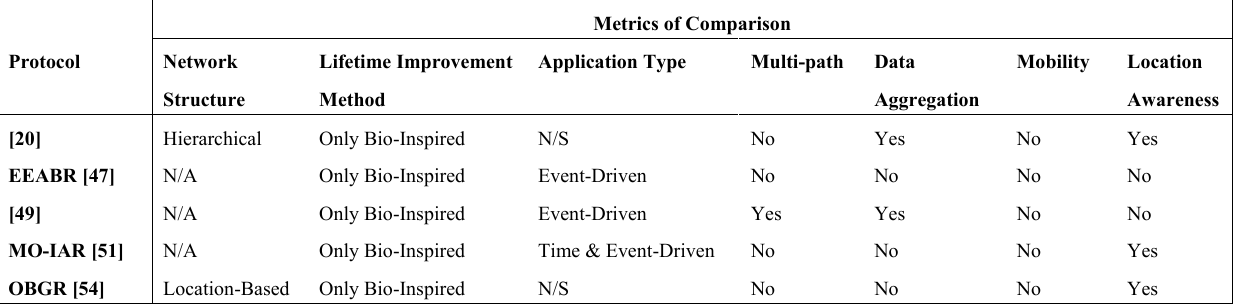
Table 4. Comparison of bio-inspired